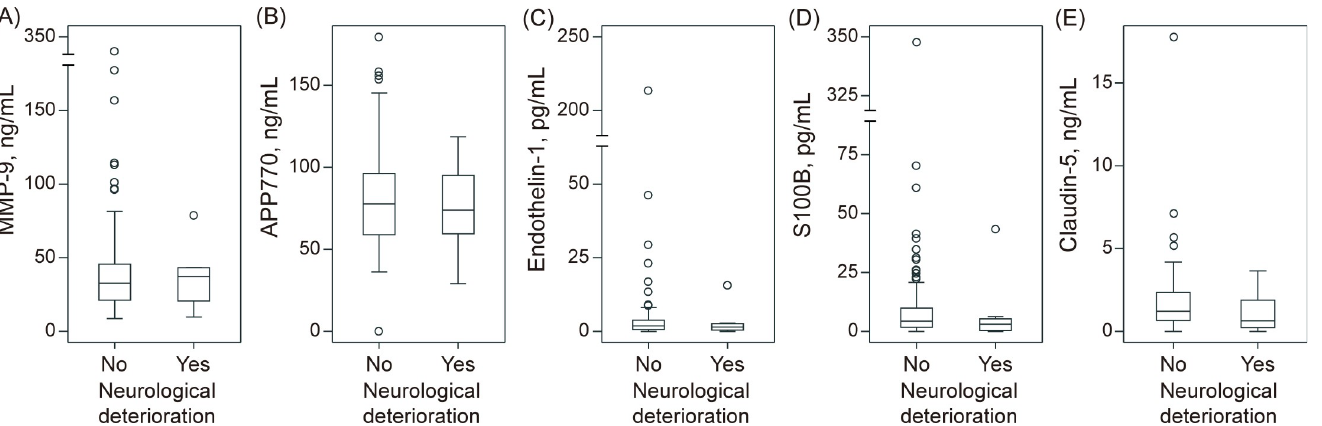
PLOS ONE | https://doi.org/10.1371/journal.pone.0256170 August 16,